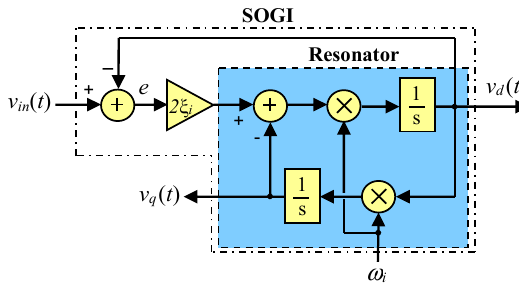
Figure 6. Block diagram of the SOGI (second-order generalized integrator) filter.